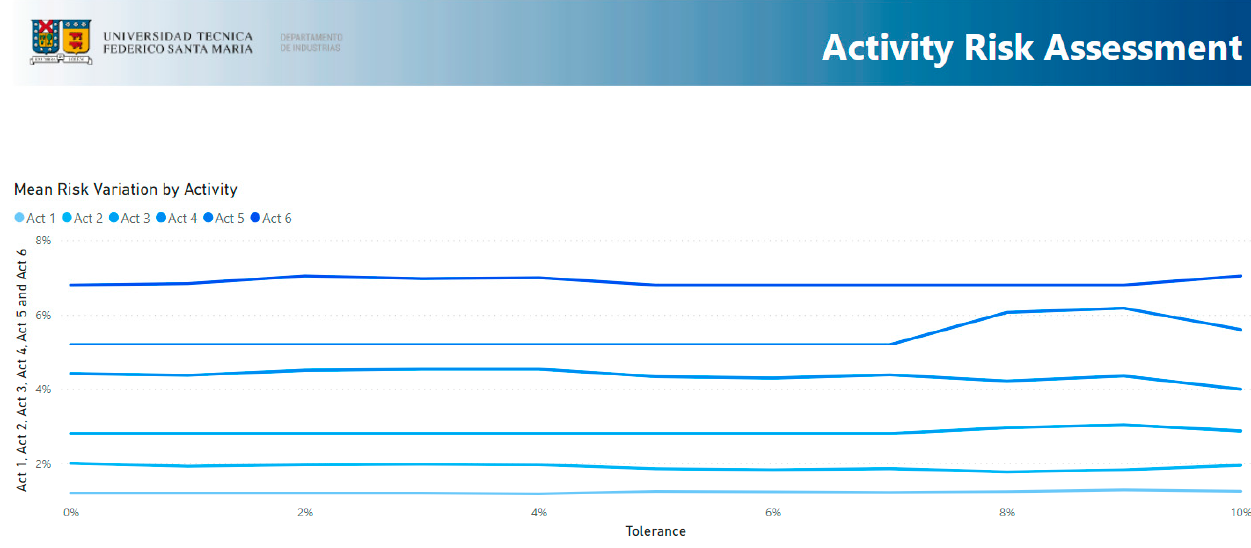
Figure 4. Activity risk assessment